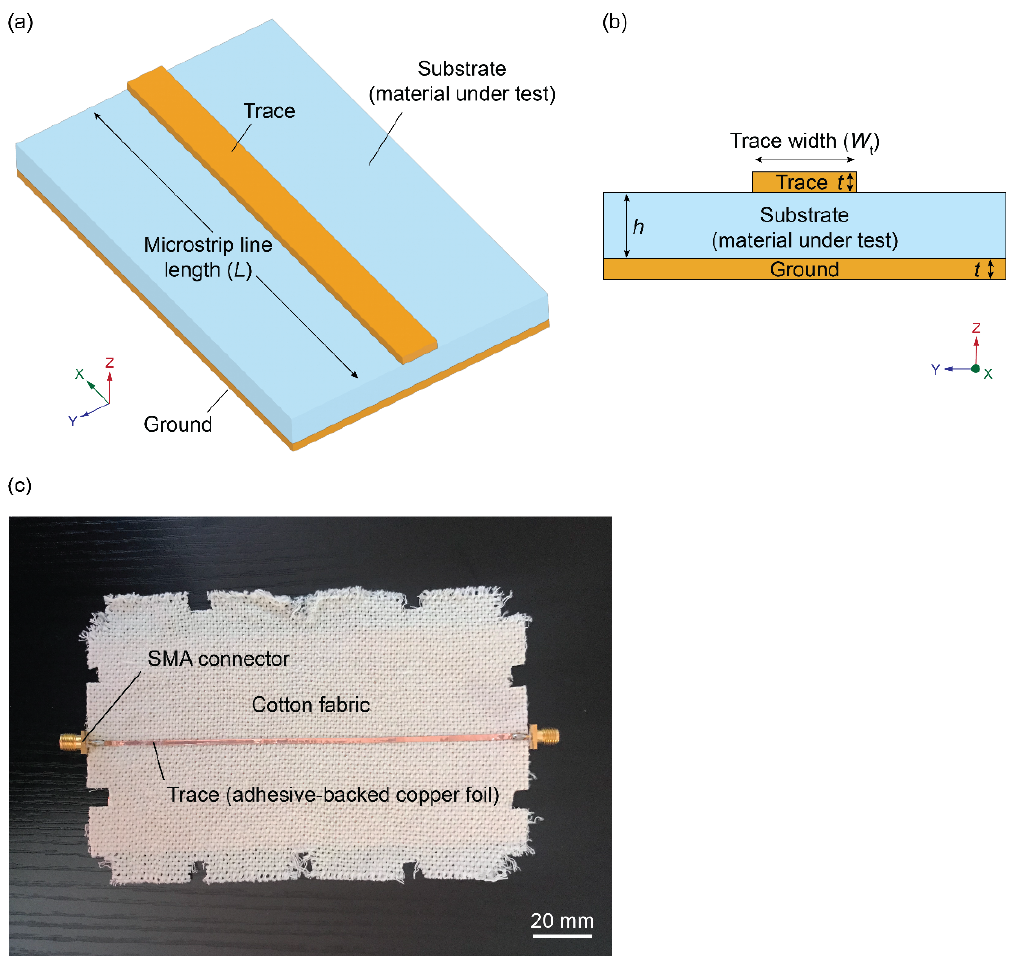
Figure 16. ( a ) Schematic illustration of a microstrip line in ( a ) perspective and ( b ) cross-sectional views. Redrawn and simplified from [41] (p. 99); and ( c ) microstrip line sample fabricated for dielectric characterization of a cotton fabric. Reprinted from [41] (p. 101). Copyright 2019 YUSUKE MUKAI